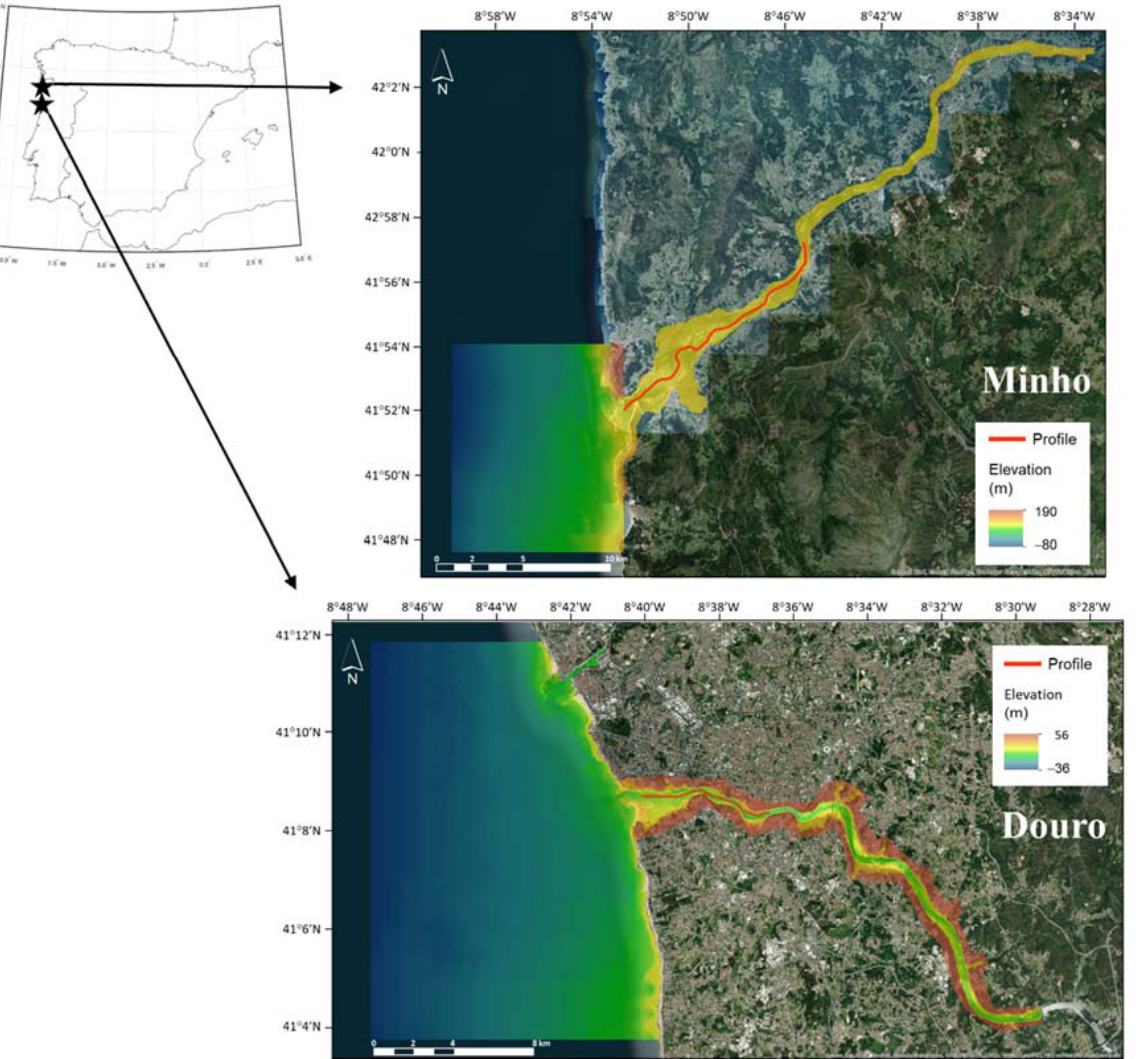
Figure 1. Location of the Douro and Minho estuaries, the topo ‐ bathymetries considered for the numerical grids construction and the longitudinal profiles considered for each estuary (base map sources: Esri, Maxar, GeoEye, Earthstar Geographics, CNES/Airbus DS, USDA, USGS, AeroGRID, IGN, and the GIS User Community).